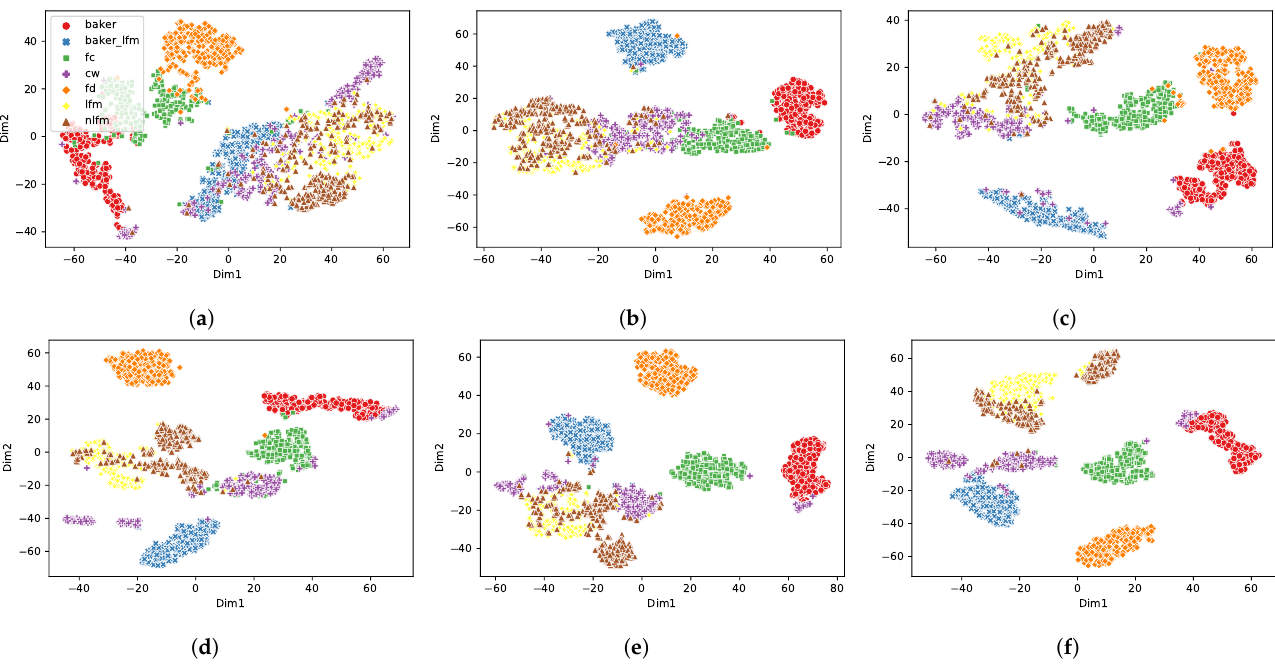
Figure 6. Visualization of learned features at the final GAP layer of ( a ) ConvNet-Sigmoid, ( b ) ConvNet-PReLU, ( c ) ConvNet-ReLU, ( d ) ConvNet-ELU, ( e ) ConvNet-SELU, and ( f ) ConvNet-SofT when the number of ConvBlocks equals 9 and SNR equals − 2